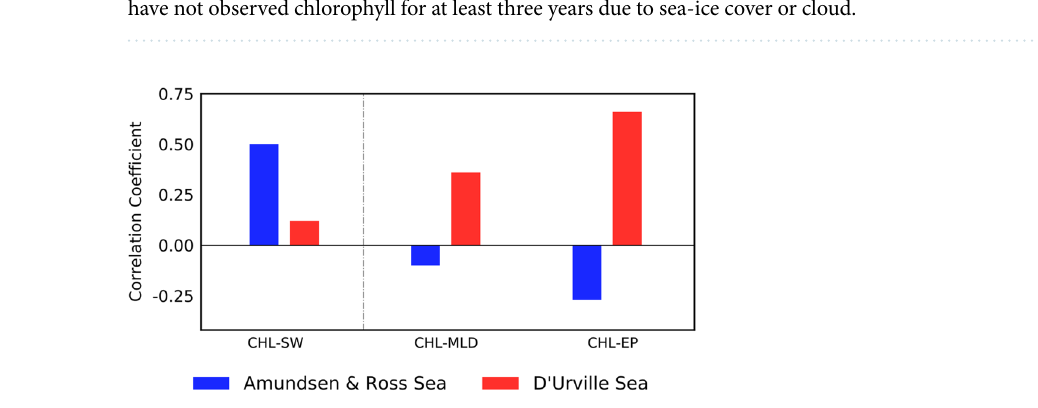
Figure 4. Local correlation coefficients of chlorophyll concentration and net shortwave flux on the ocean surface, MLD, and Ekman pumping velocity. These correlation coefficients are calculated using the spatially averaged time series of each region. The blue and red bars represent the Amundsen-Ross and D’Urville Sea regions,